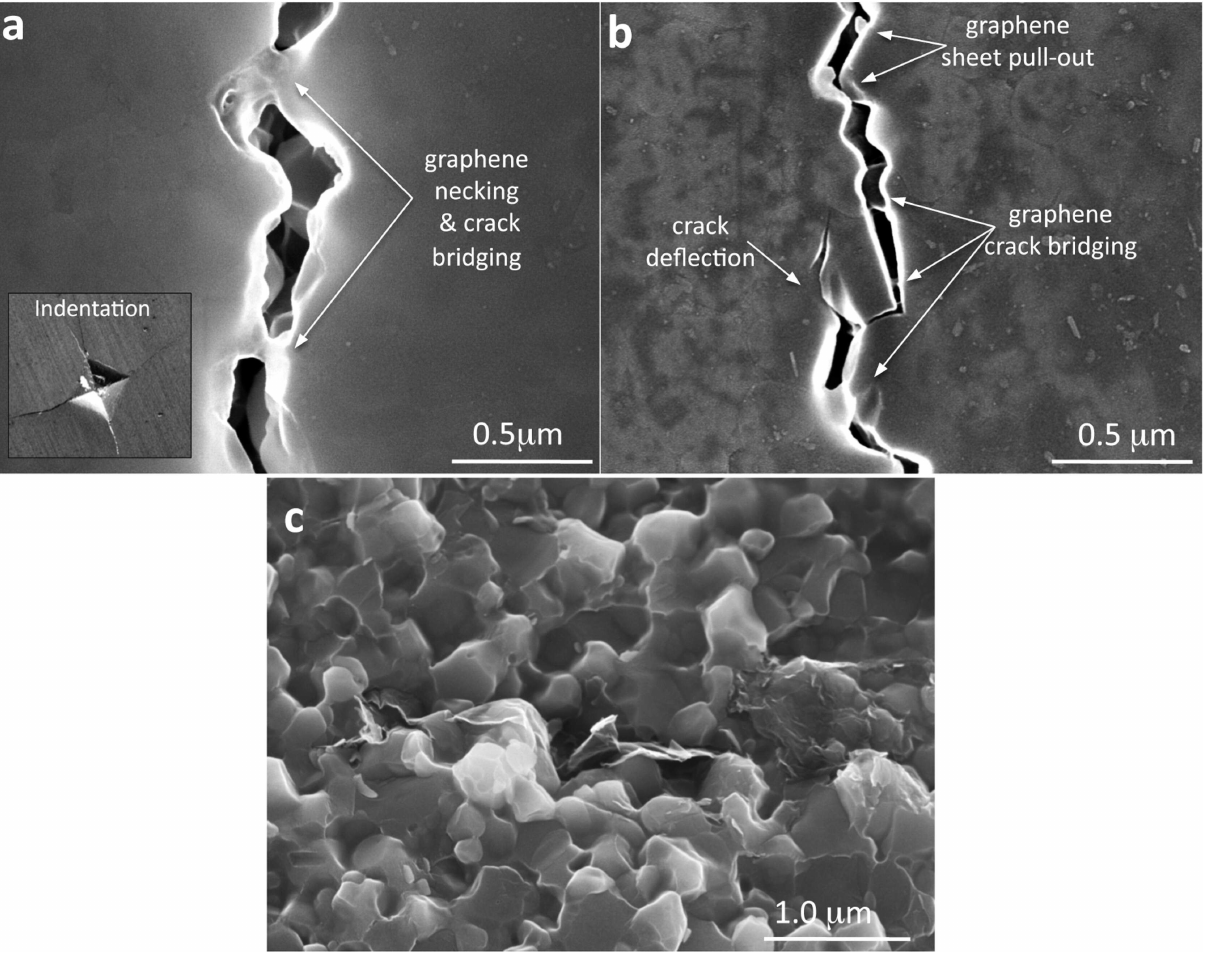
Figure 6: Toughening mechanisms in GPL-Si 3 N 4 nanocomposites. (a)Micro-hardness testing resulting in a crack. (b) Crack following a tortuous crack propagation path. (c) 3D toughening mechanisms of the GPL-Si 3 N 4 nanocomposite